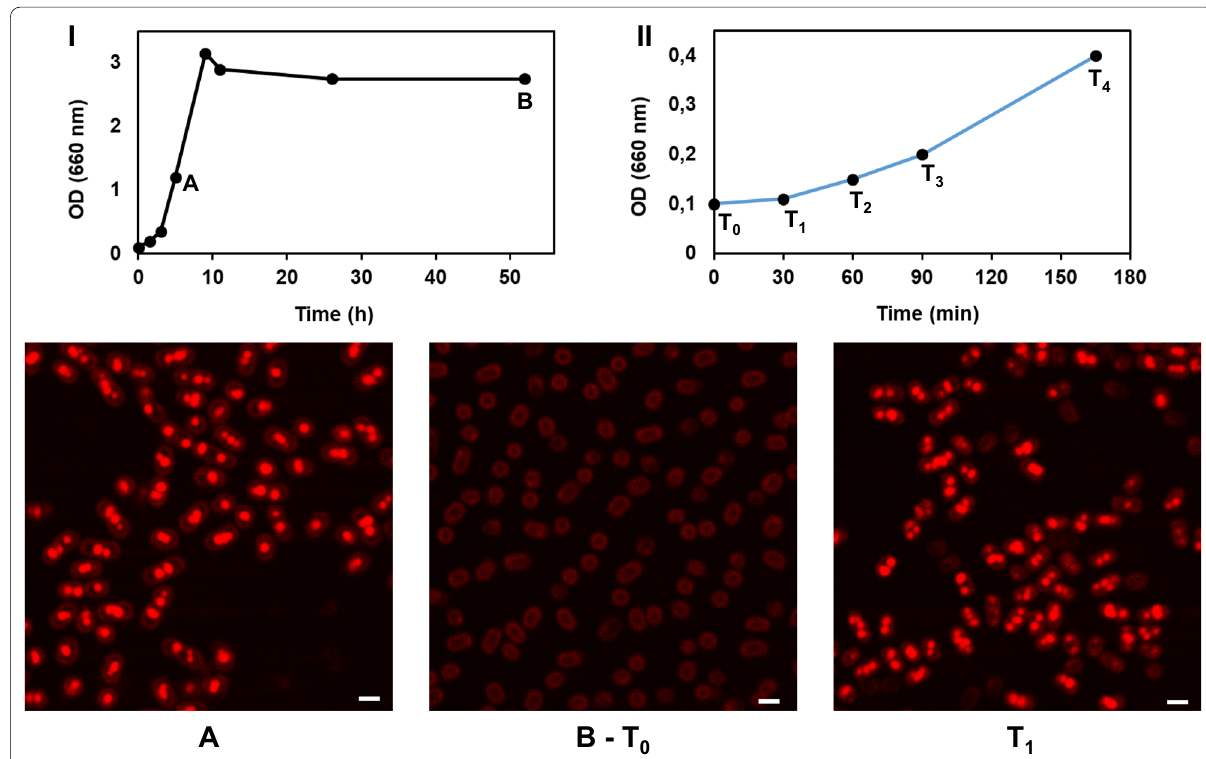
Fig. 2 The PHB granules appear before the first cellular division. A Mid‑exponential phase cells. B Late stationary phase cells, used as inoculum (T 0 ) for the second time‑series experiment. T 1 Cells after 30 min of shaking at 34 °C and 300 rpm. The microscopy images of T2, T3 and T4 samples are not shown in Fig. 2 because they are very similar to the T1 sample. The scale bar is 1 µm